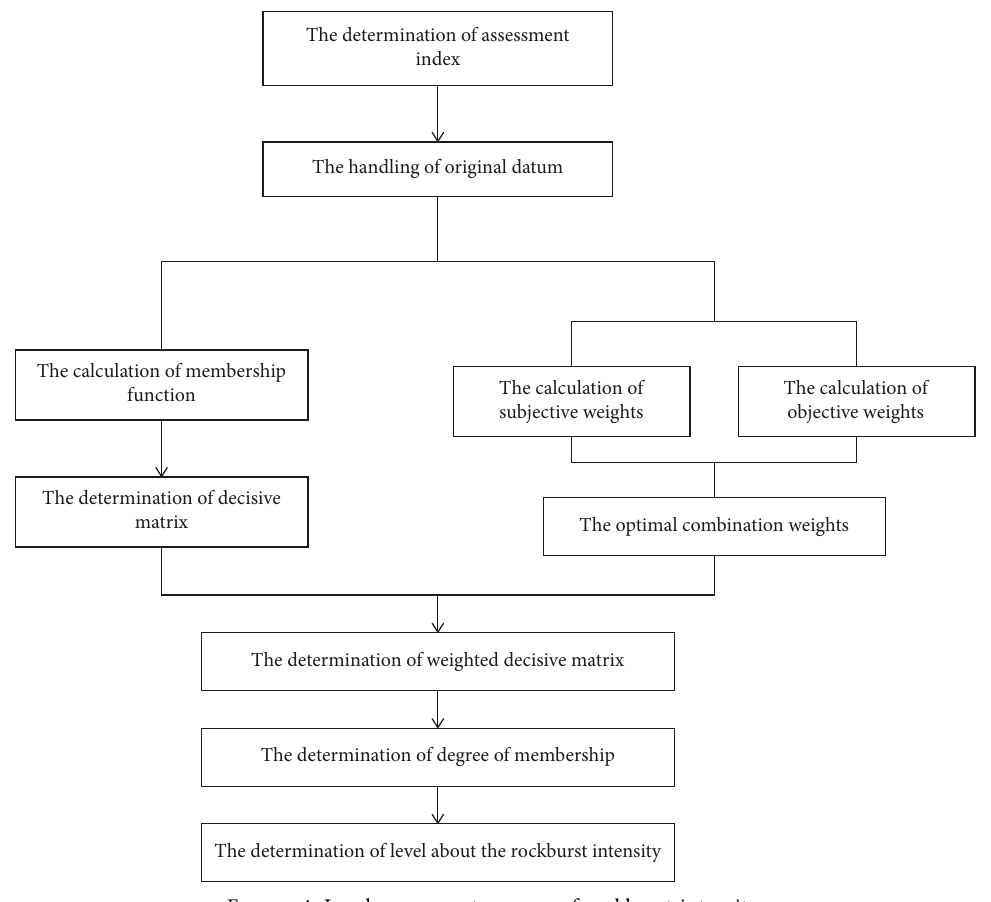
Figure 4: Level assessment process of rockburst